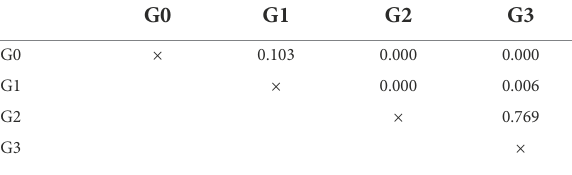
TABLE 3 Behavioral data for six experimental conditions.